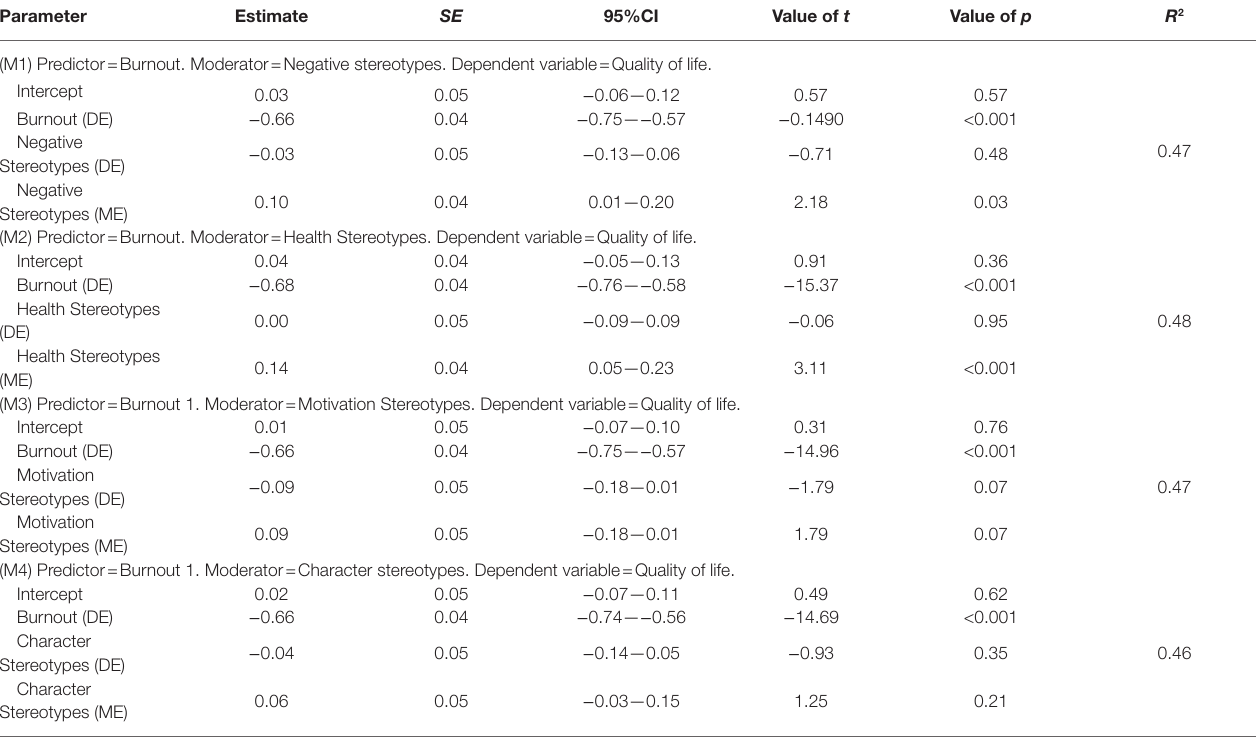
TABLE 2 | Results of moderator models of negative stereotypes (M1–M4).